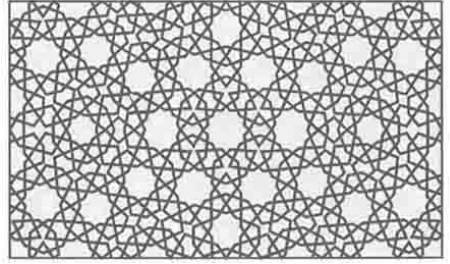
Figure 3: Example of girih patterns with 9-pointed, 10-pointed, 11-pointed, and 12-pointed stars [12].